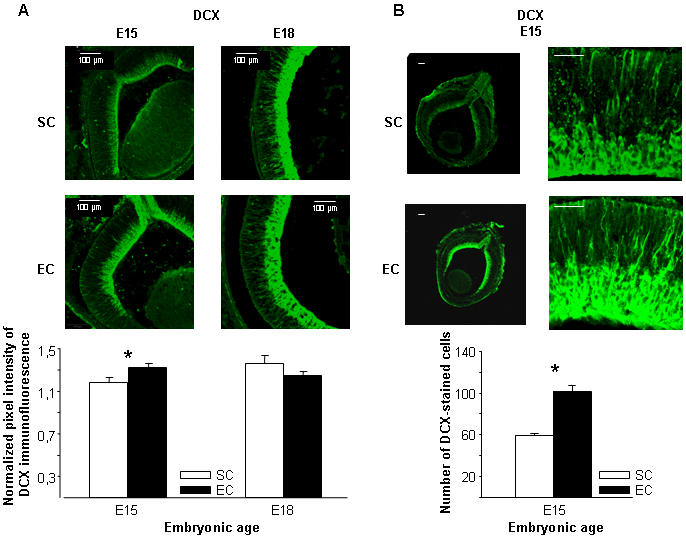
Anticipated migration of retinal neural progenitors in EC fetuses.(A, top) Micrographs of EC and SC retinal sections immunostained for double-cortin (DCX) at E15 and E18. DCX expression was increased in EC rats at E15. (A, bottom) Quantitative analysis of DCX immunofluorescence intensity in the outer retinal layers of SC and EC rats. Two-ways ANOVA showed a statistical interaction between animal age and housing condition (p = 0.02). A Pairwise Multiple Comparison Procedure (Holm-Sidak method) revealed that the two groups were statistically different at E15 (p = 0.03), but not at E18 (p = 0.19). (B, top) Micrographs of EC and SC retinal sections immunostained for double-cortin (DCX) at E15, acquired at 5× (left, scale bar: 100 µm) or 20× (right, scale bar: 50 µm) magnification to count the number of migrating cells. (B, bottom) Number of cells stained for DCX in the outer retinal layers of SC and EC rats. The number of DCX-labeled cells was higher in EC than in SC embryos (Mann-Whitney rank sum Test, p<0.05). Bars indicate s.e.m.